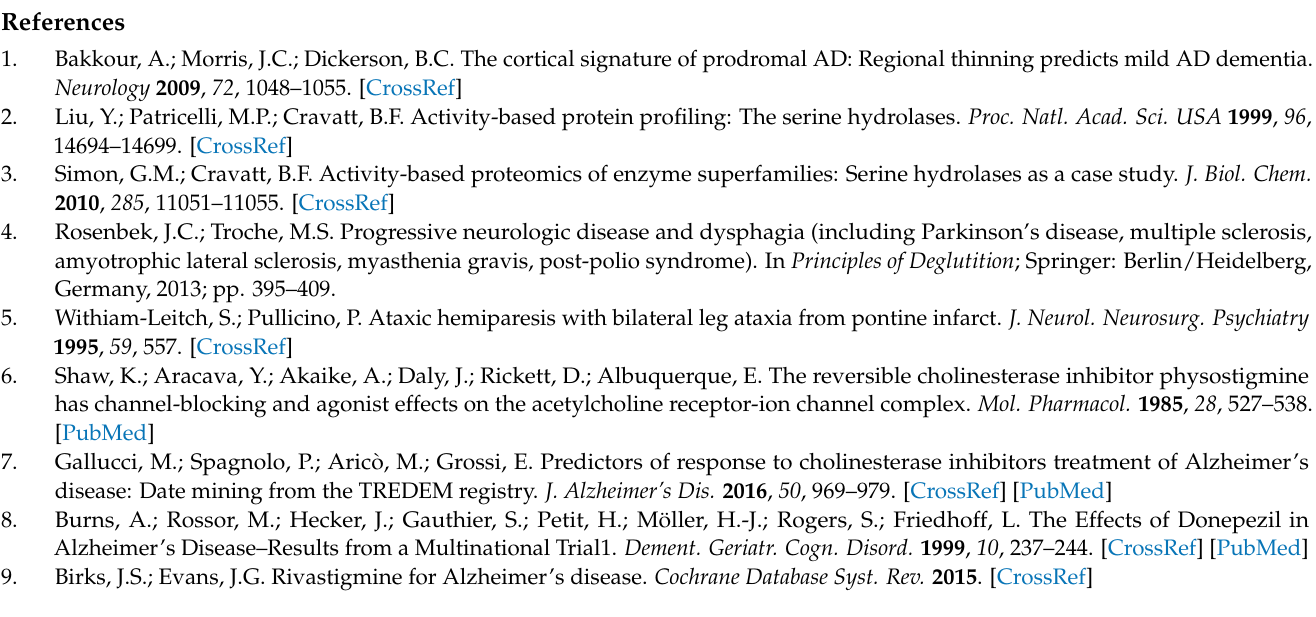
Table S1: UV/VIS, IR and Molar conductivities of the metal complexes, Table S2: Elemental analysis and magnetic susceptibility data of the complexes, Table S3: Bond lengths [Å] and angles [ ◦ ] for